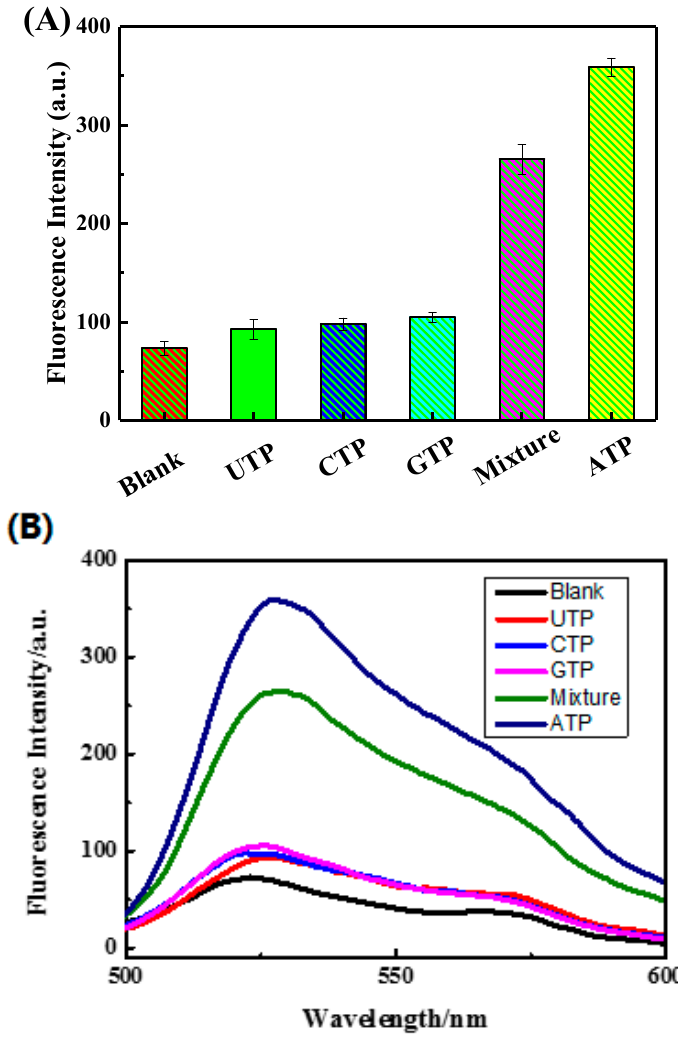
Figure 6. ( A ) The selectivity assays. Blank sensing system consisted of DNA-T, DNA-M, DNA-M ′ , GO and PicoGreen dye; ( B ) ATP sensing system consisted of the blank sensing system and 200 µL of 10 µM ATP; UTP sensing system consisted of the blank sensing system and 200 µL of 10 µM UTP; CTP sensing system consisted of the blank sensing system and 200 µL of 10 µM CTP; GTP sensing system consisted of the blank sensing system and 200 µL of 10 µM GTP; Mixture sensing system consisted of the blank sensing system, 200 µL of 10 µM ATP, 200 µL of 10 µM UTP, 200 µL of 10 µM CTP, and 200 µL of 10 µM GTP.